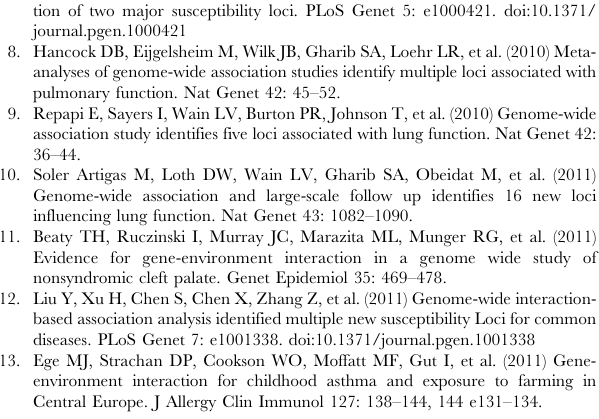
Table S6 SNPs from each of 16 chromosomal regions with P values between 5 6 10 2 8 and 1 6 10 2 6 for the joint meta-analysis of SNP and SNP-by-smoking (ever-smoking or pack-years) in relation to pulmonary function (FEV 1 /FVC or FEV 1 ). A hyphen (‘‘ 2 ’’) indicates P . 1 6 10 2 6 . For each regression model, the SNP having the smallest P JMA from each locus is shown. Table S7 SNPs with P , 1 6 10 2 6 from the 1 degree-of-freedom meta-analysis of regression coefficients corresponding to the SNP-by-smoking (ever-smoking or pack-years) interaction term in relation to FEV 1 /FVC. No SNPs exceeded the standard genome-wide significance threshold ( P , 5 6 10 2 8 ). A hyphen (‘‘ 2 ’’) indicates P . 1 6 10 2 6 . For each regression model, the SNP having the smallest P INT from each locus is shown. Table S8 Study-specific results for the genome-wide significant SNP rs11654749 (coded allele: T), located between the KCNJ2 and SOX9 genes. b estimates and P values are shown for the SNP main association ( b SNP and P SNP ) and interactive association ( b INT and P INT ) by ever- smoking in relation to FEV 1 . The P values corresponding to the joint test of SNP main and interactive associations are also shown. Table S9 Look-up evaluation of main SNP associations with cigarette smoking phenotypes using data generated by the Oxford- GlaxoSmithKline Consortium (N = 41,150), for the most signifi- cant SNP from each of the three novel loci implicated at genome- wide significance in the joint meta-analysis. Table S10 mRNA expression profiling of three candidate genes in the human lung and periphery. Primer sequences are provided in Table S5. A ‘‘ + ’’ sign indicates presence of the transcript, and ‘‘ 2 ’’ indicates its absence. All products were sequence verified. Table S11 Questionnaire data used to ascertain cigarette smoking history (ever-smoking), amount, and duration across the 19 studies. Smoking amount and duration were used together to calculate pack-years. Table S12 Details of single nucleotide polymorphism (SNP) genotyping, quality control (QC), imputation, and statistical analysis across the 19 studies.